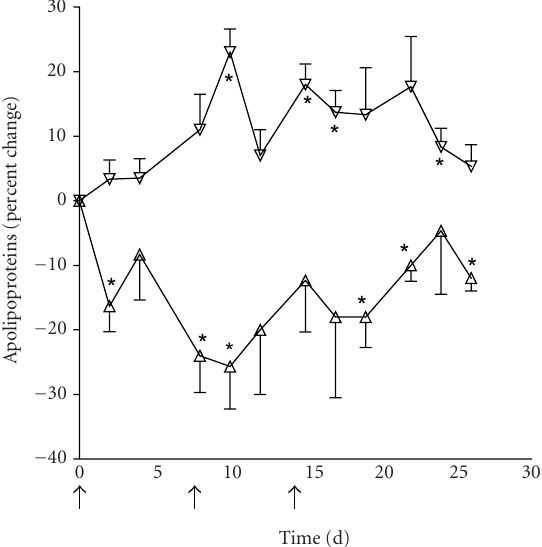
Figure 6. Average percent change in apolipoprotein A-I ( ∇ ) and apolipoprotein E ( ∆ ) concentrations in baboons after in- travenous injections of the truncated apoC-I peptide at 10, 15, and 20 mg/kg on days 0, 7, and 14, respectively (arrows). The baboons were fed the HCHF diet. Values are expressed as mean ± SE, n = 3. Values significantly di ff erent from those at day 0 are marked by an asterisk ( P < . 05).